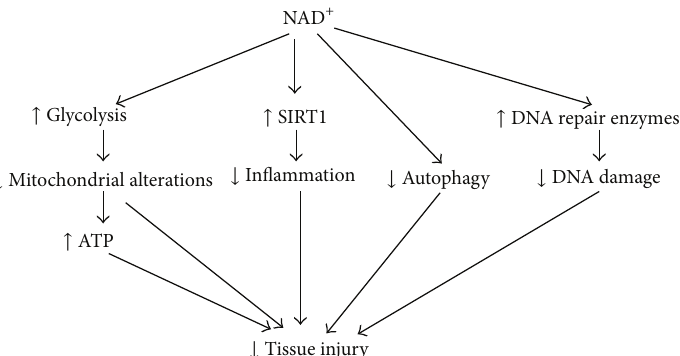
Figure 1: Diagrammatic presentation of thepotential mechanisms underlying NAD + administration-produced protective effects on thetissue injury in cerebral ischemia, head trauma, or SR X-ray